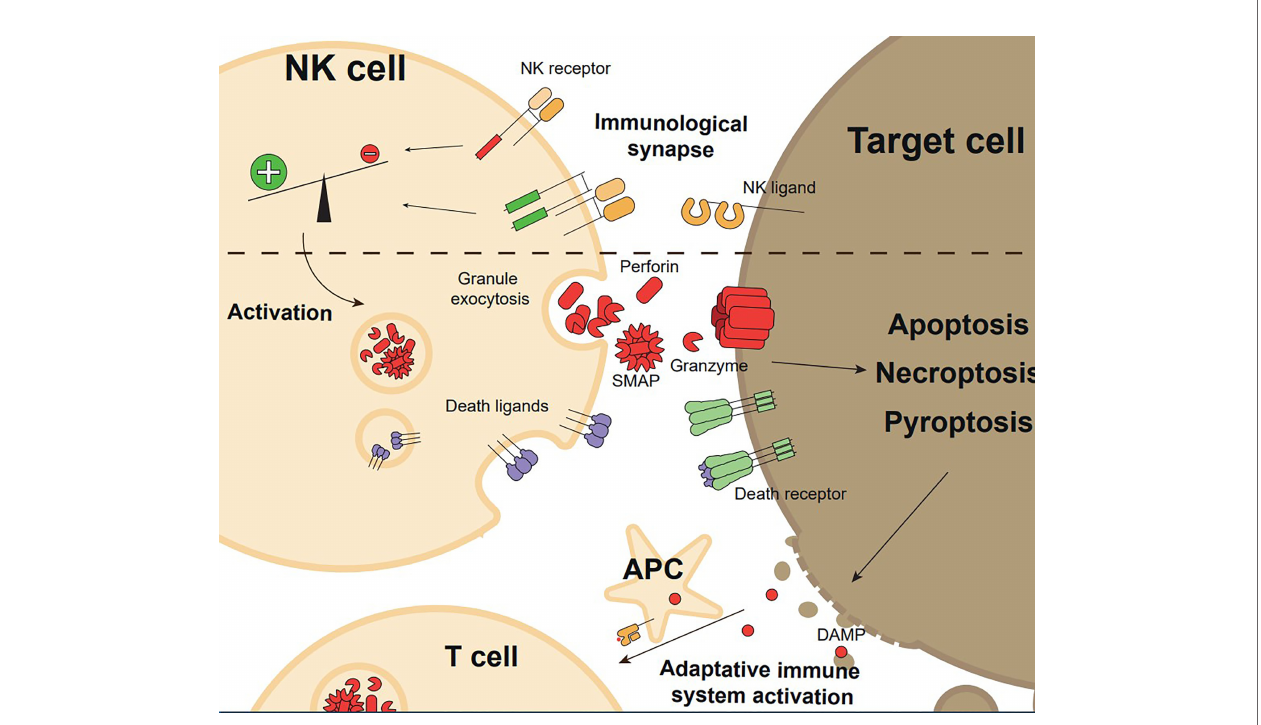
FIGURE 1 | Overview of the execution and functional consequences of NK cell mediated cytotoxicity. Target cell recognition through NK cell receptor-ligand interaction and formation of the immunological synapse with a pro-activating signals balance promote NK cell activation. Upon activation, NK cells exert their effector functions, granule exocytosis, or expression of death ligands, inducing target cell killing by regulated cell death (apoptosis, necroptosis, or pyroptosis). Target cell death generates Danger Associated Molecular Patterns (DAMPs) and releases tumour antigens, which induces adaptative immune system